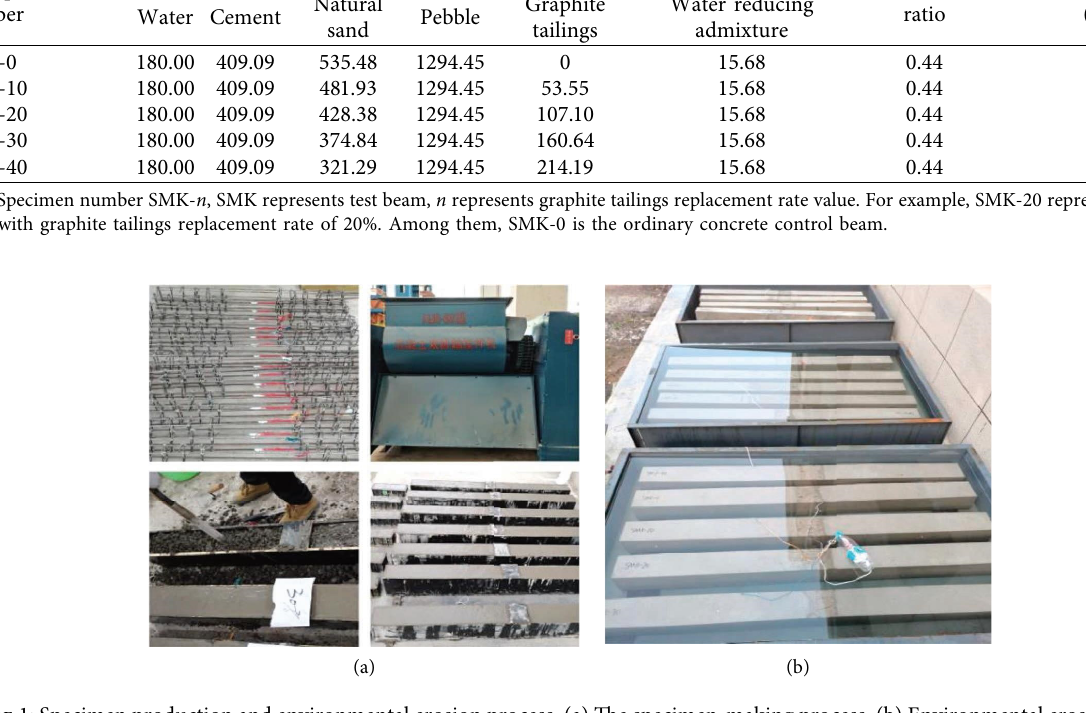
Figure 1: Specimen production and environmental erosion process. (a) Te specimen-making process. (b) Environmental erosion process.